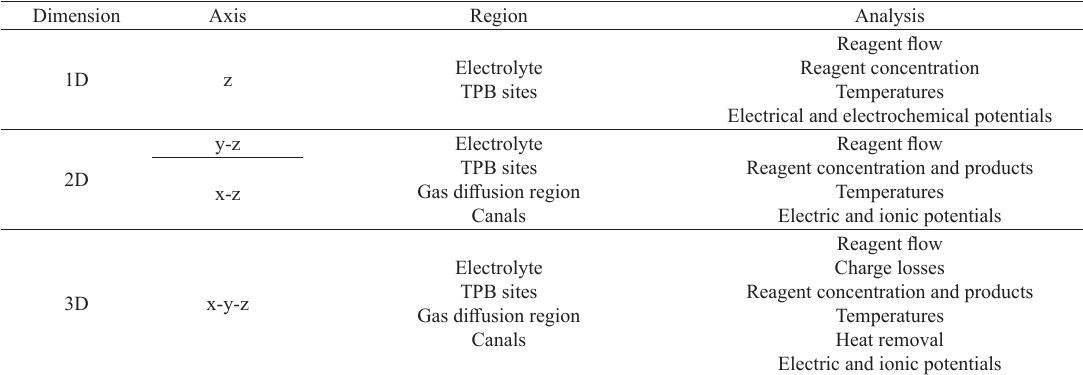
Table 1. Modeling domains applicable in the characterization of problems according to the design. Dimension